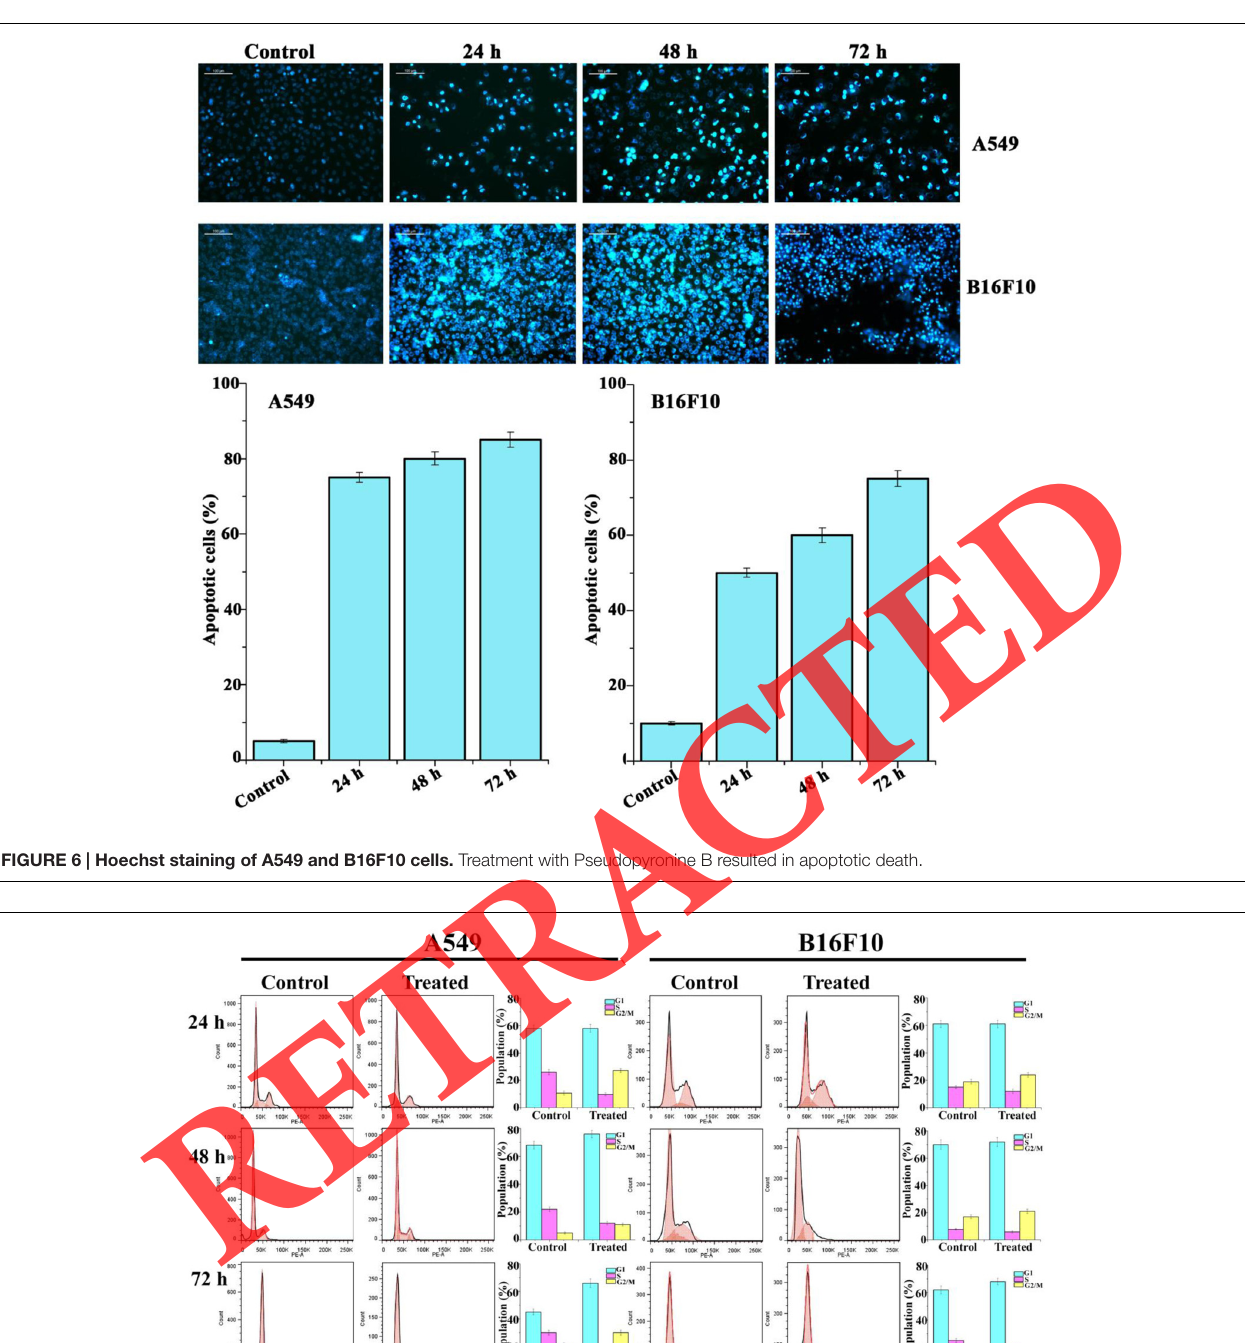
FIGURE 7 | Effect of Pseudopyronine B against A549 and B16F10 on cell cycle. The experiments where performed in three replication and results in bar diagram were expressed as mean ± standard